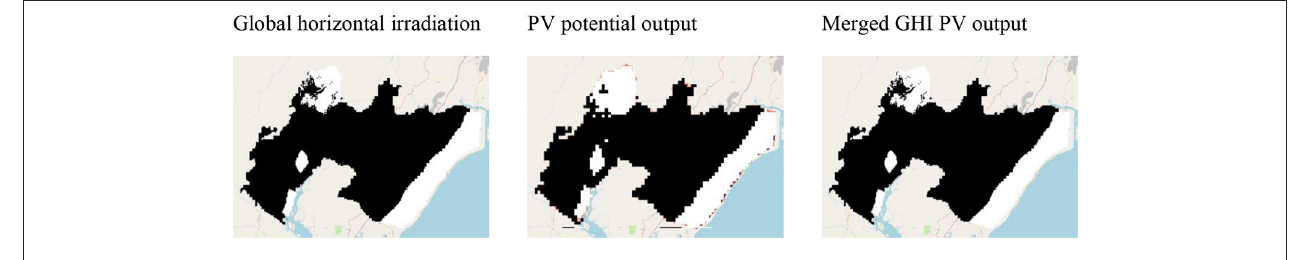
FIGURE 10 | Locations with high and low solar potentials.